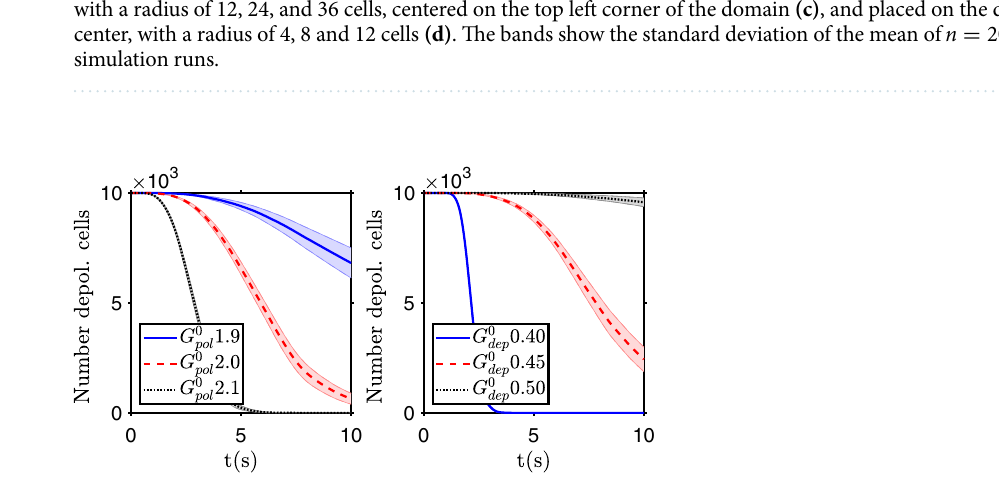
Figure 4. Repolarization therapies. Evolution of the number of depolarized cells for therapies that increase the polarization ion channel conductivity ( G 0 pol , left) or decrease the depolarization ion channel conductivity ( G 0 dep , right). Initially all the cells were depolarized. The bands show the standard deviation of the mean of n = 20 simulation